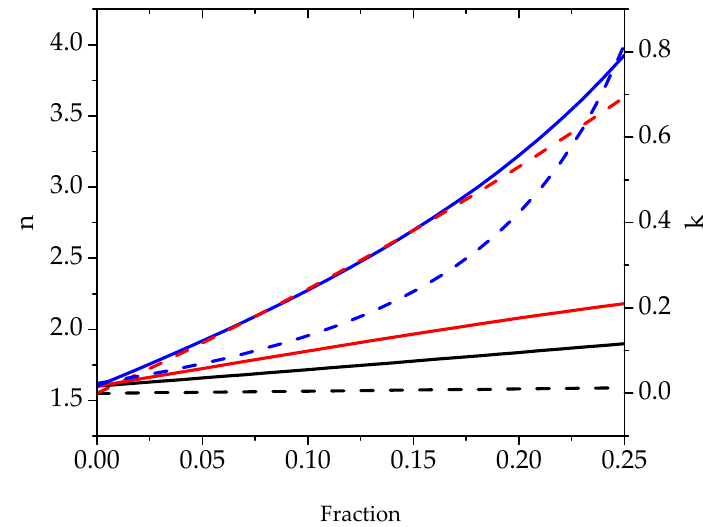
Figure 3. Effective refractive indices computed with the Maxwell–Garnett (MG) method (solid lines: the real part of refractive index n; dashed lines: the imaginary part of refractive index k. Black line: m 2 = 3.102 + 0.0925i; red line: m 2 = 1.46 + 2.75i; blue line: m 2 = 0.15 + 3.15i).